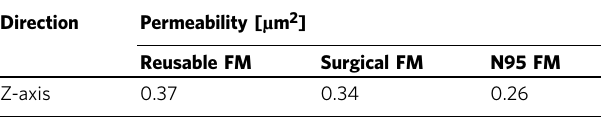
Table 3 The absolute permeabilities of reusable, surgical and N95 face masks within the sub-volume domain at Z-axis